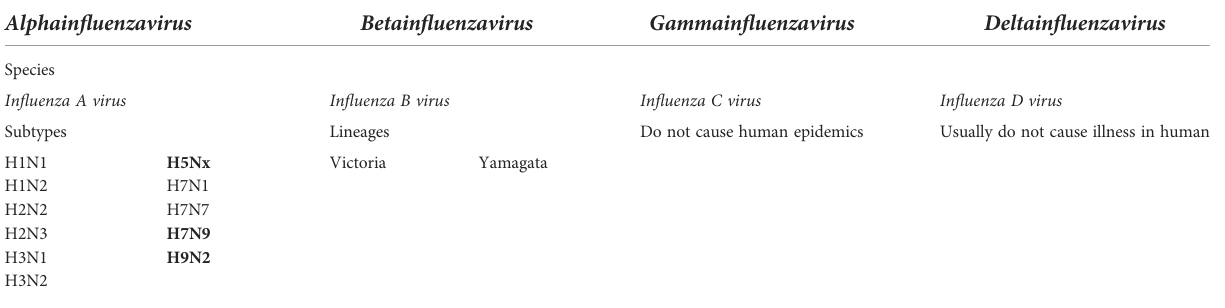
TABLE 1 Classi fi cation of in fl uenza viruses and subtypes of concern.